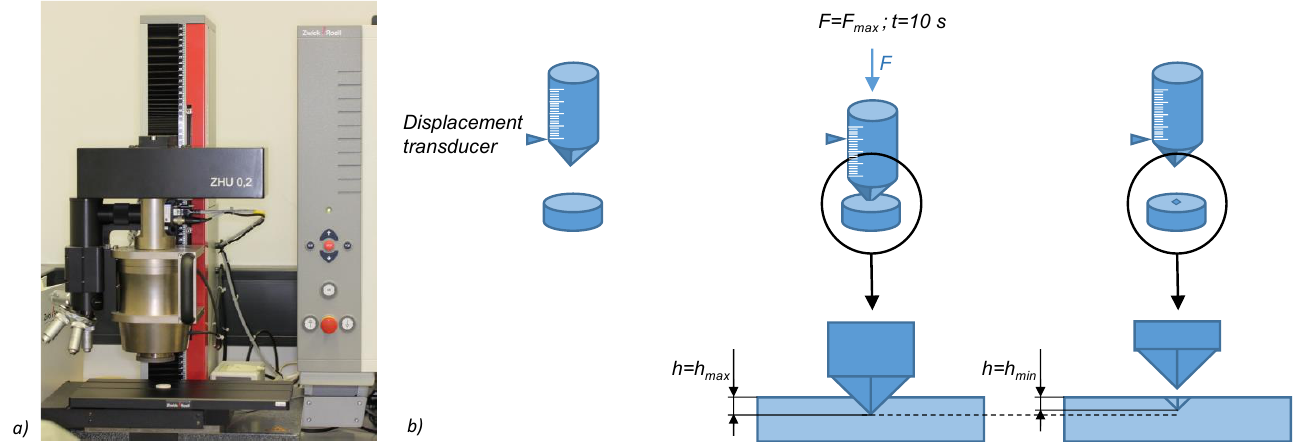
Figure 1. ( a ) ZwickiLine Z2.5 and ( b ) schematic test procedure with maximum indentation depth (h max ) at application of maximum force (F max ) and residual indentation depth (h min ) after stress relaxation.